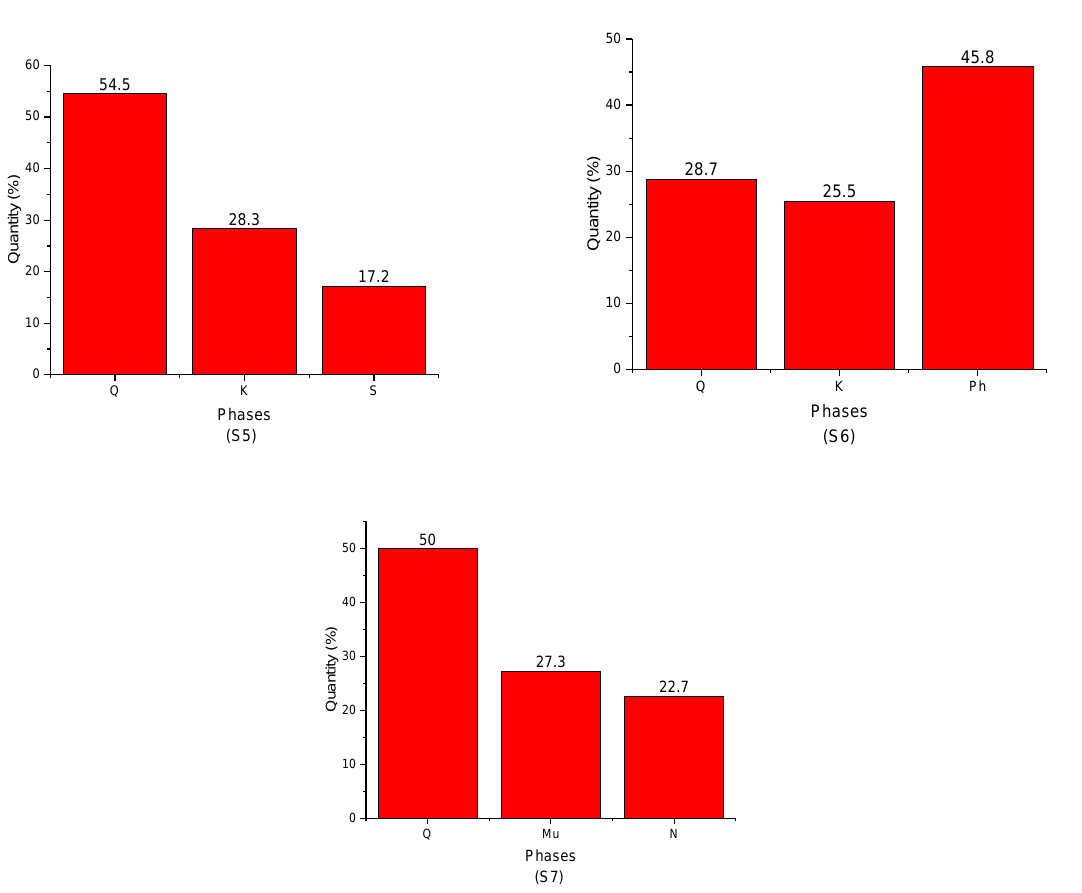
Figure 3. Evolution of the proportions of the identified phases as a function of clay samples: (S1) green-yellow clay — Adrar, (S2) green clay — Adrar, (S3) red clay — Adrar, (S4) red clay — Reggan, (S5) white clay — Reggan, (S6) white-red clay — Reggan, and (S7) red clay — Timimoune.